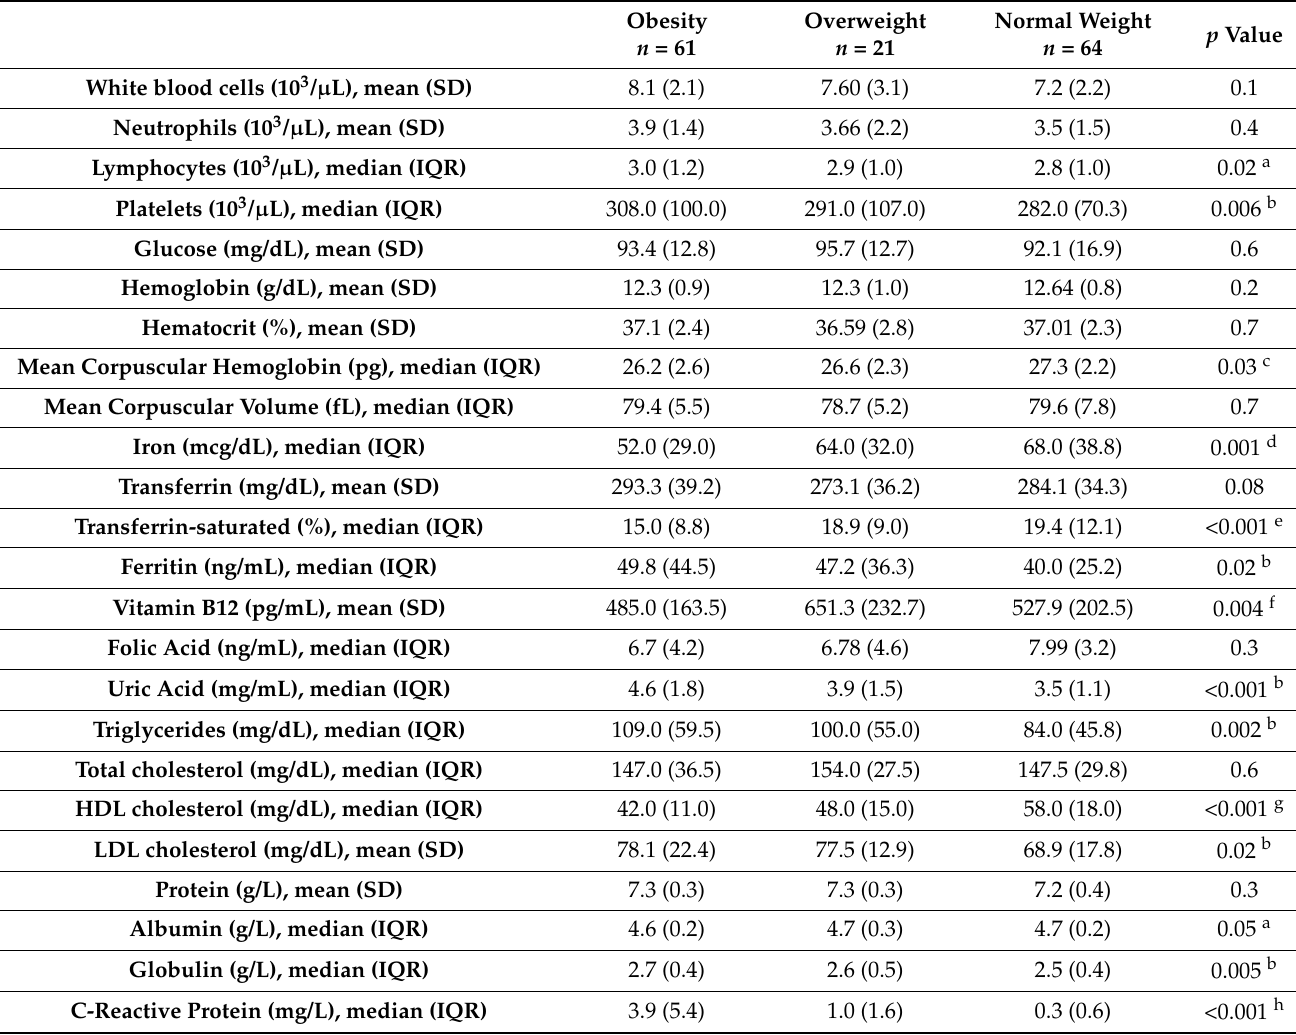
Table 3. Differences in the plasma/serum levels of nutritional and inflammatory markers among children with normal weight, overweight, and